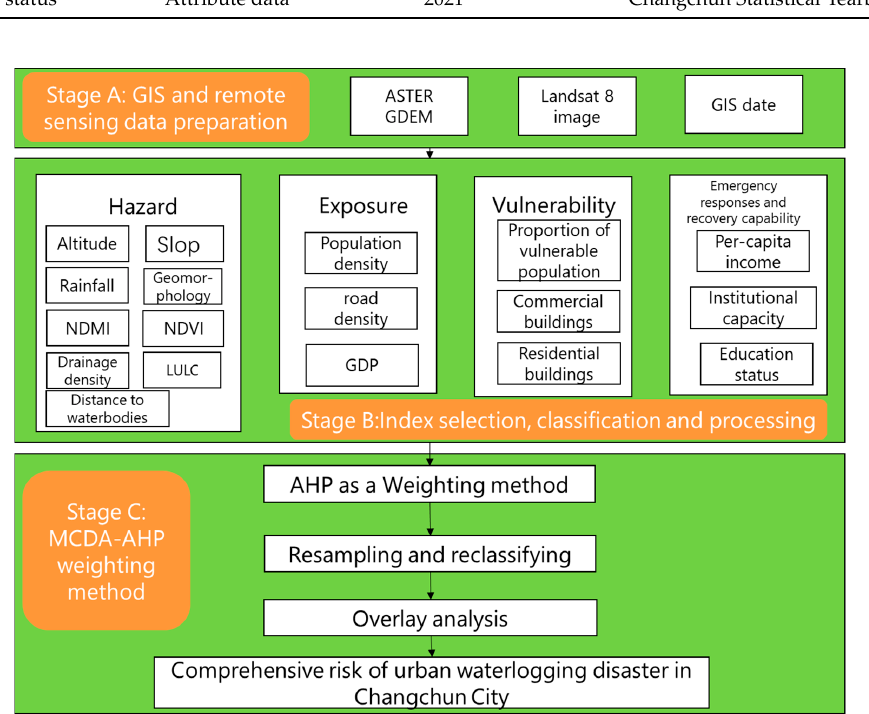
Figure 2. Workflow of the study.